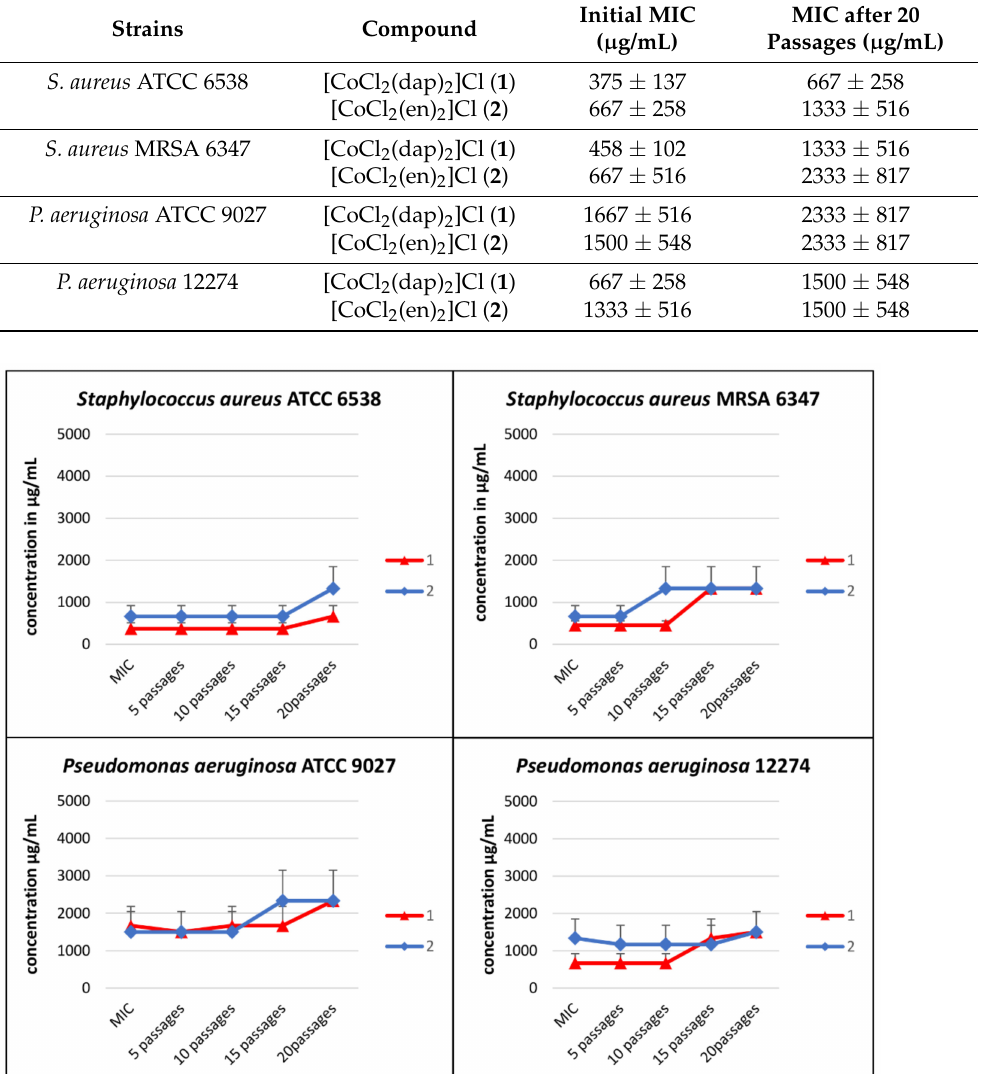
Table 2. MIC ( µ g/mL) values in the presence of [CoCl 2 (dap) 2 ]Cl ( 1 ) and [CoCl 2 (en) 2 ]Cl ( 2 ) passaging results for selected bacterial strains.